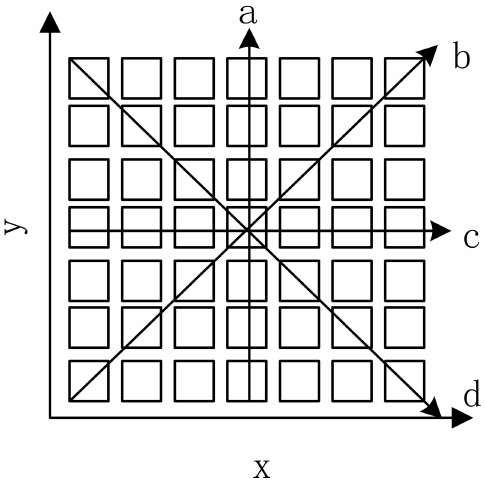
Figure 4. Schematic diagram of gradient